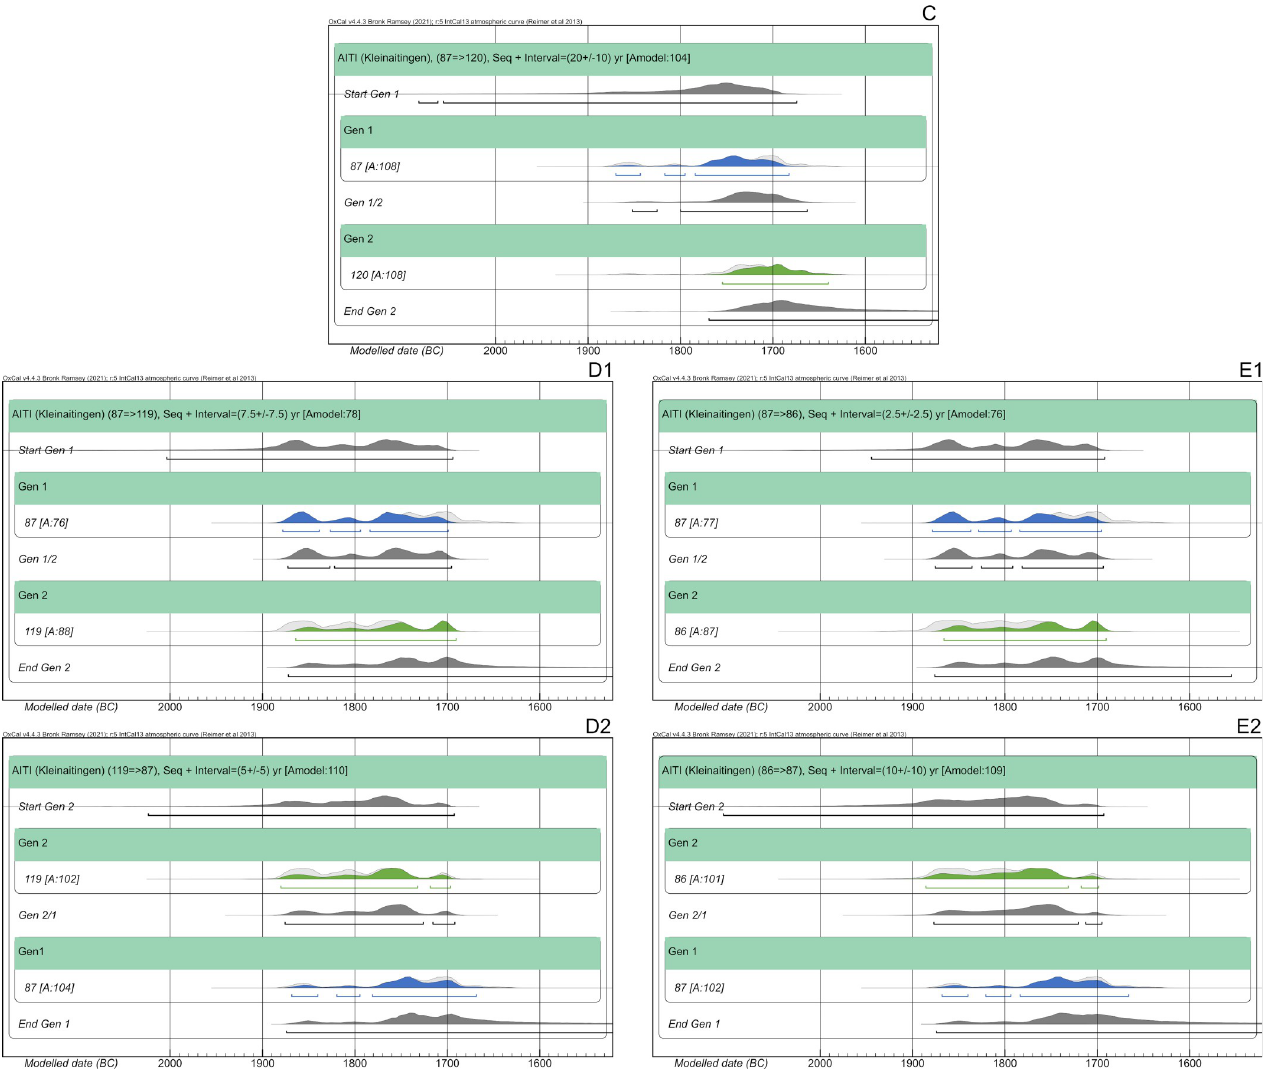
Fig 23. Results of pairwise Bayesian modelling of the mother (AITI_87) and her sons. (light grey) unmodelled probabilities; (coloured) modelled probabilities. The switched chronological order of AITI_87 and AITI_119 (D1 and D2), as well as AITI_86 (E1 and E2), are plotted separately (see S8 Table Sheet 7, 11, 15, 19 and